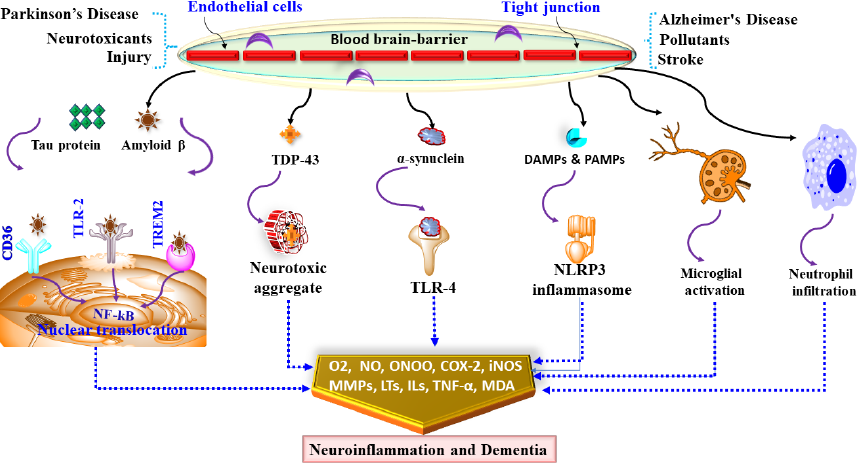
Figure 2. Showing mediators and neuroinflammatory modulators and dementia. Coexisting neurological disorders such as Alzheimer’s disease, Parkinson’s disease and exposure to neurotoxic stimulus cause damage to BBB via alteration in endothelial cells and tight junctions. Damaged BBB causes NLRP3, TLR-4 and microglial activation, macrophage infiltration and nuclear translocation